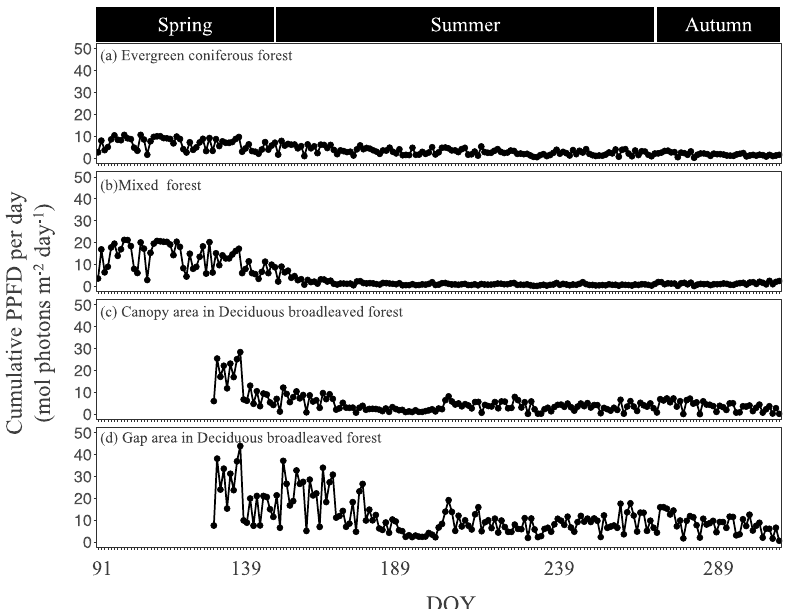
Figure 3. Daily cumulative photosynthetic photon flux density (PPFD) in the four sites during the growing period. DOY, day of year.